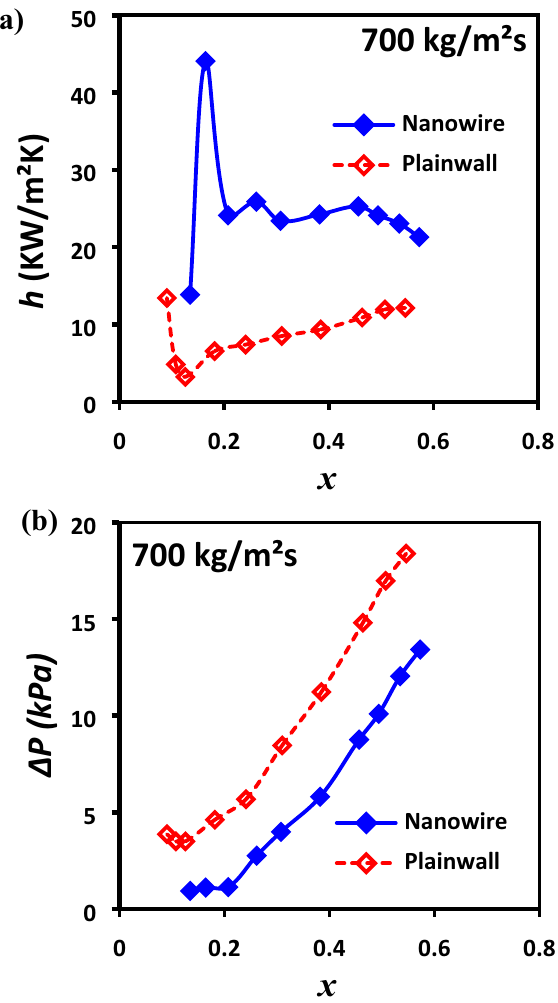
Figure 15. Comparison of ( a ) heat transfer coefficient, h; ( b ) pressure drop, ∆P as a function of vapor quality between silicon nanowire and plainwall